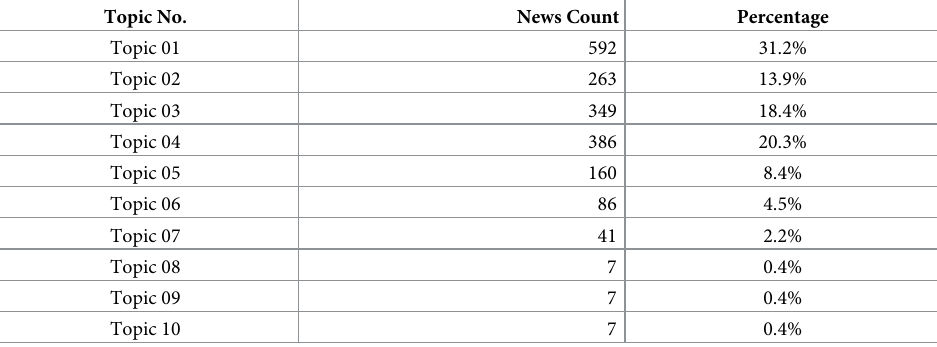
Table 5. News topic popularity statistics. Topic